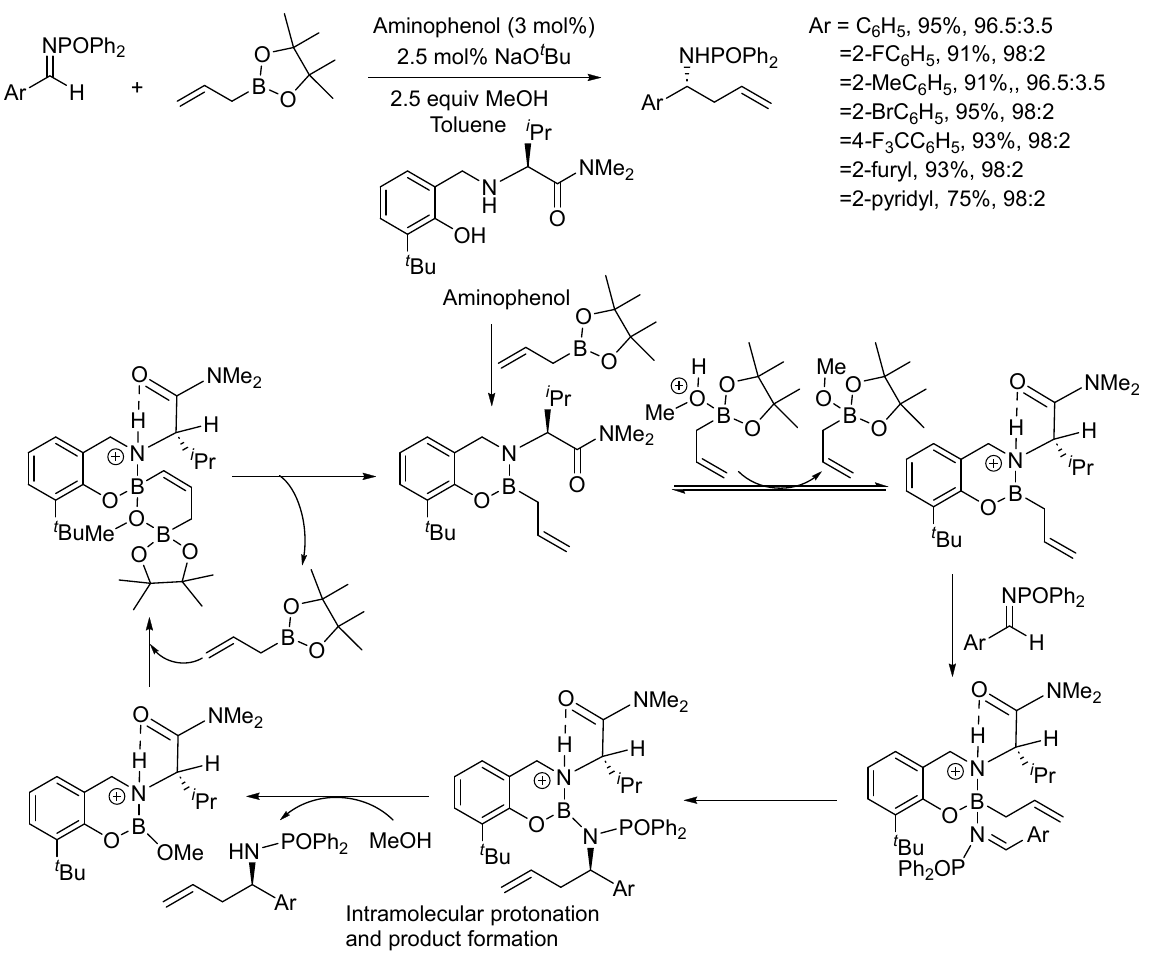
Scheme 16. Enantioselective synthesis of amines using chiral small molecule